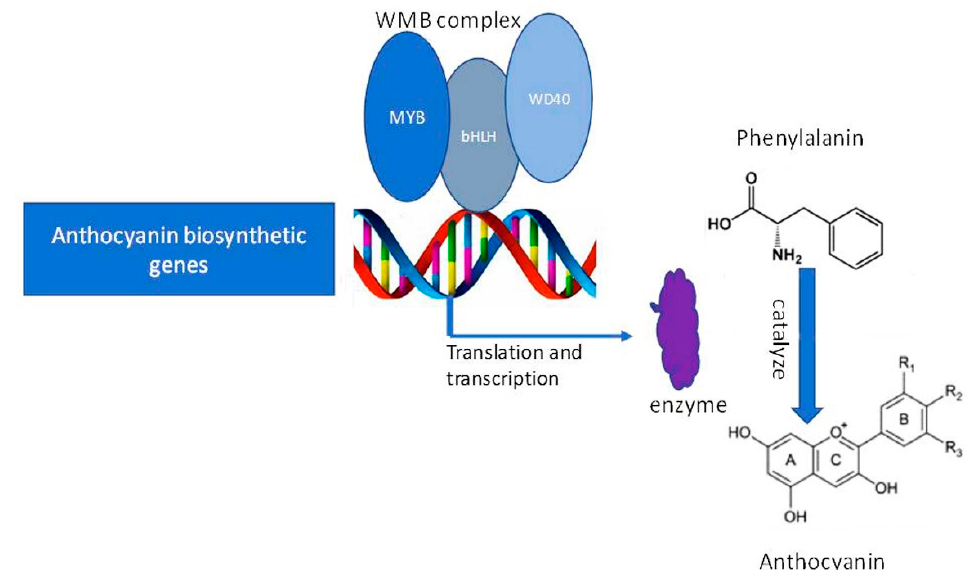
Figure 10. Proposed model for summarizing the transcriptional complex; MYB, bHLH, and WD40 proteins coordinately regulate anthocyanin accumulation through binding to the anthocyanin biosynthetic structural genes.